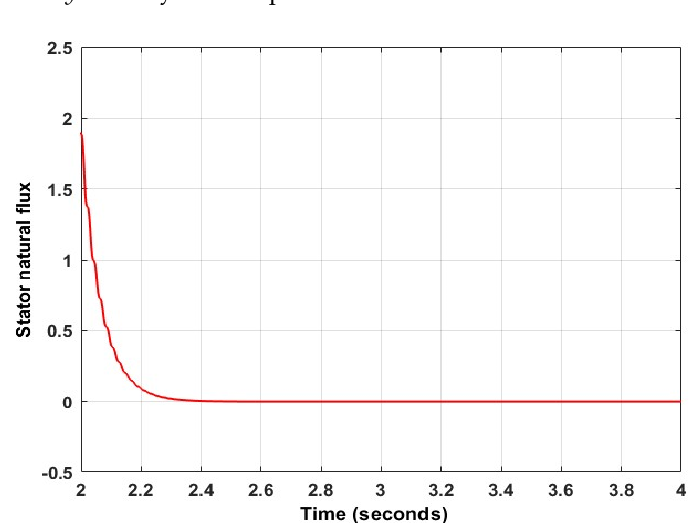
Figure 5. Stator natural flux for short-circuit rotor terminals.